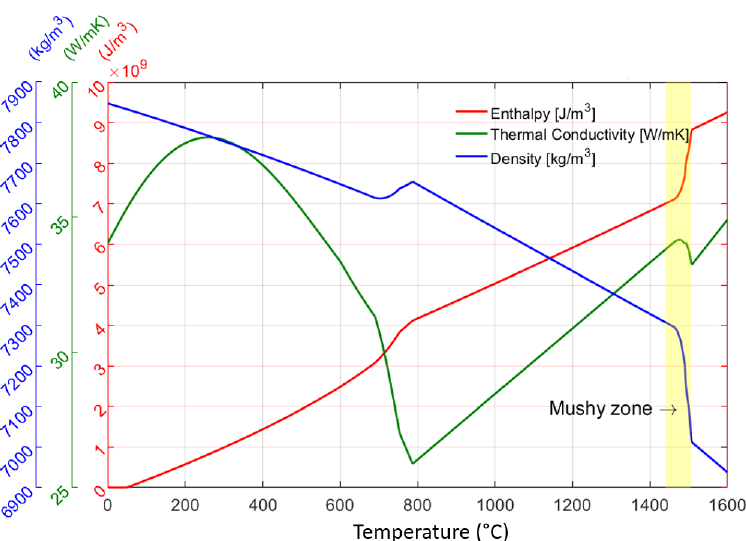
Figure 4. Thermophysical properties of structural steel 18CrNiMo7-6.